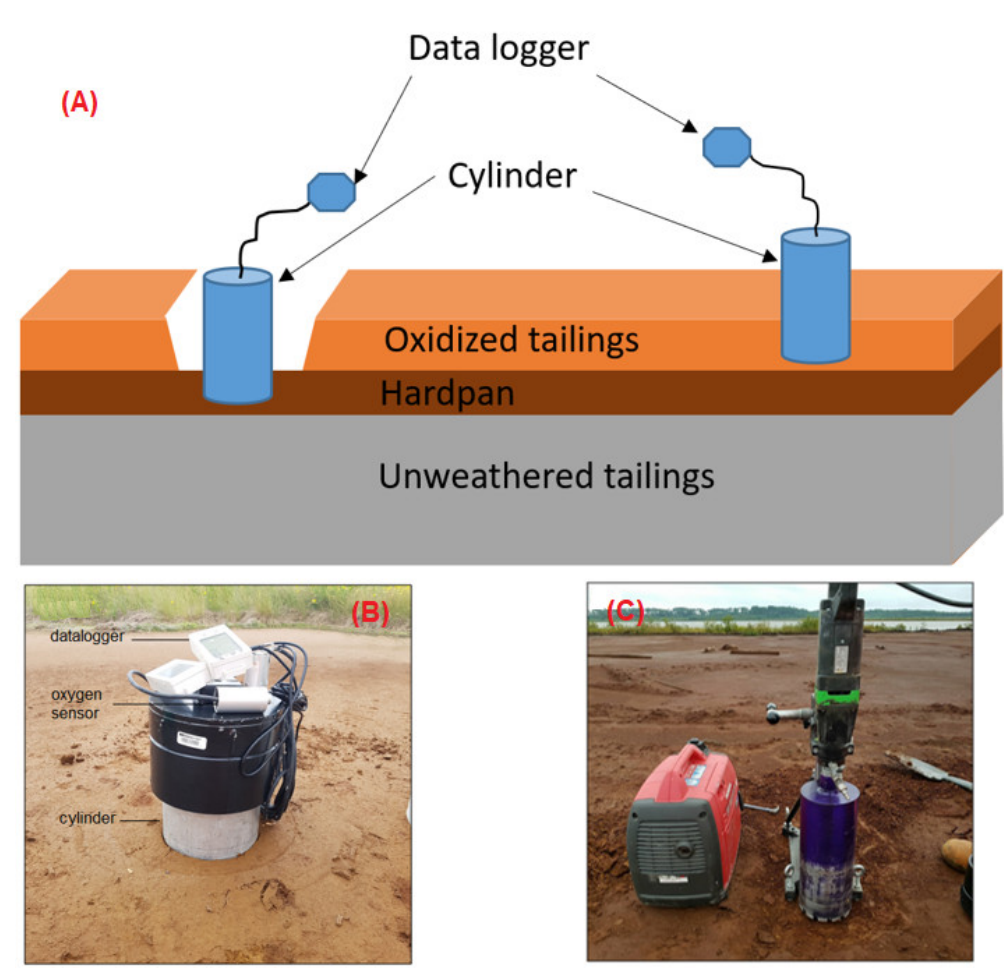
Figure 3. Images showing design of oxygen consumption tests. ( A ) schematic illustration of oxygen consumption tests of tailings and hardpan, ( B ) datalogger and oxygen sensor, ( C ) drill used to the cylinder in the hardpan.